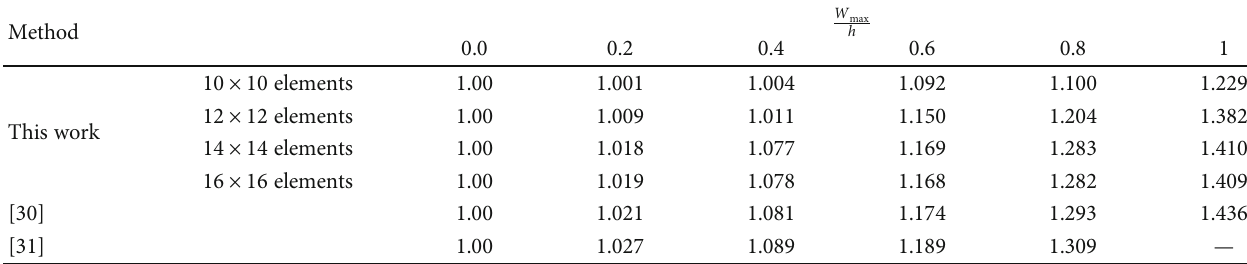
ω NL / L of FGM square plate,